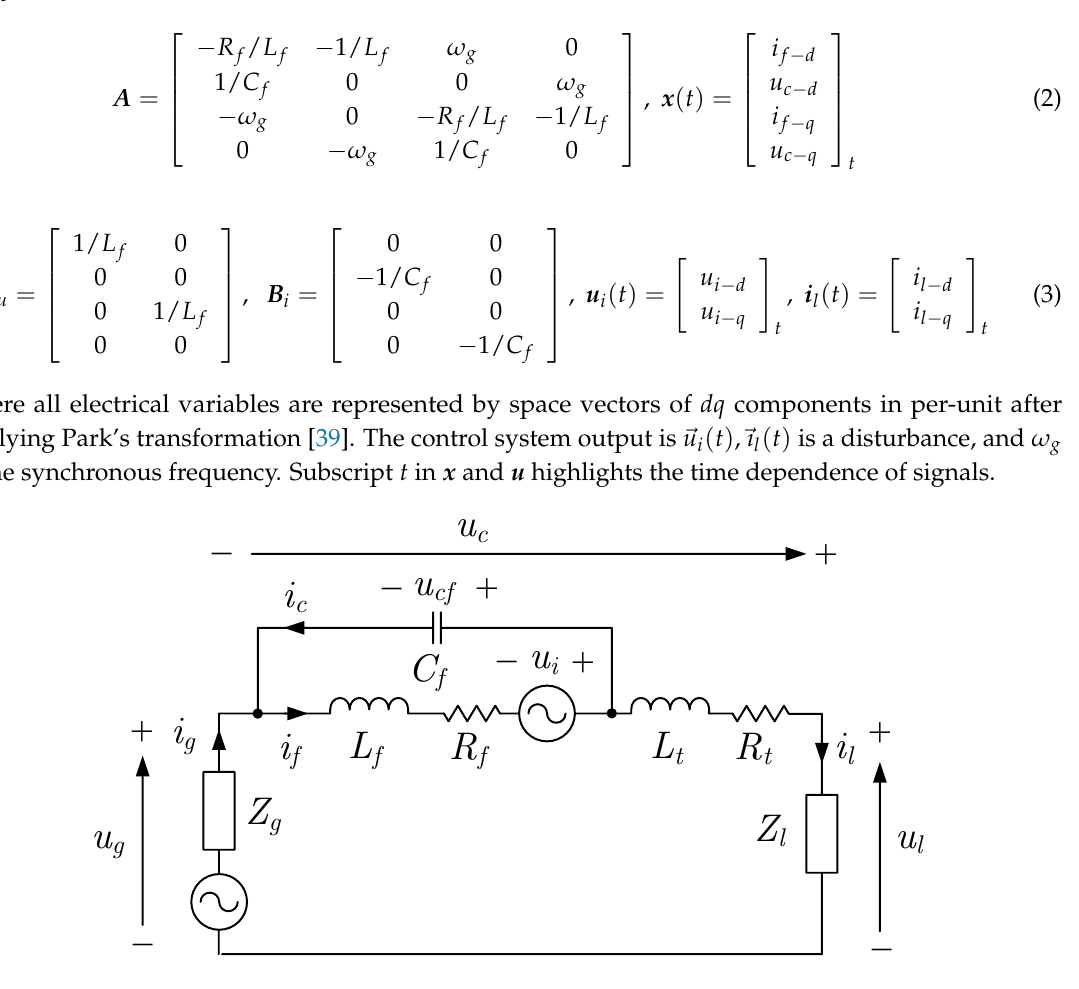
Figure 4. Single-phase electrical model for the